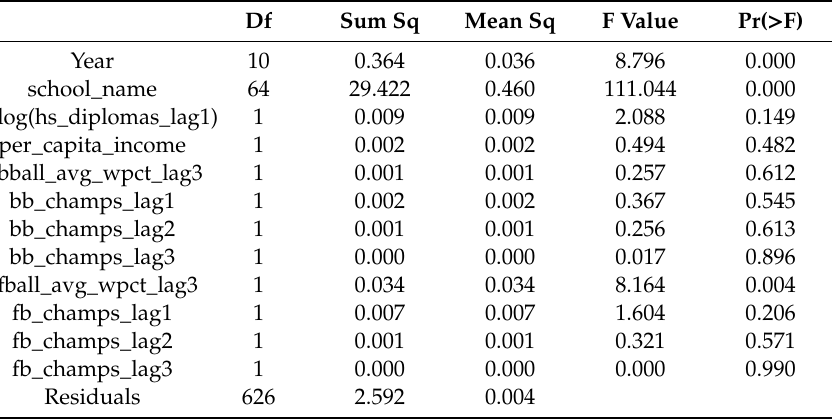
Table A9. ANOVA table for